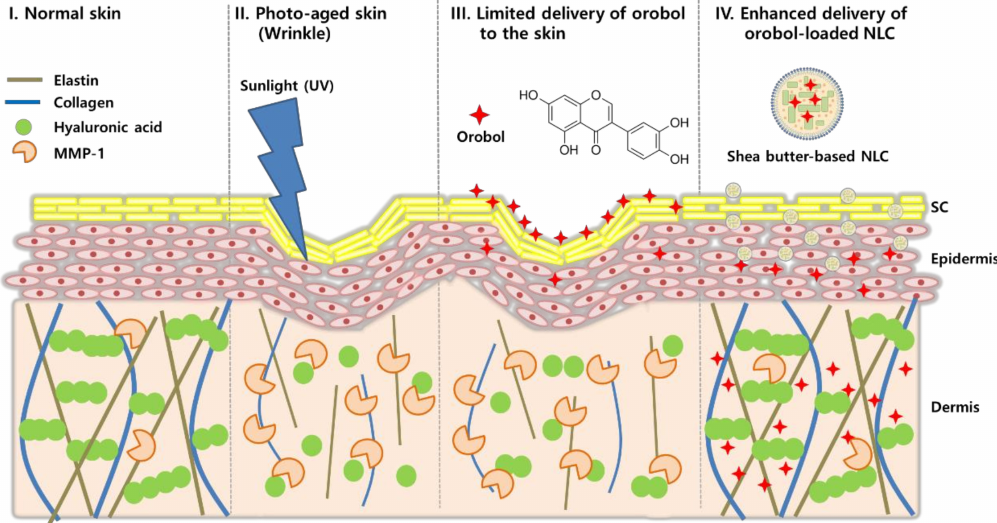
Figure 1. Scheme of orobol-loaded nanostructured lipid carriers (NLCs) to enhance photostability and topical skin